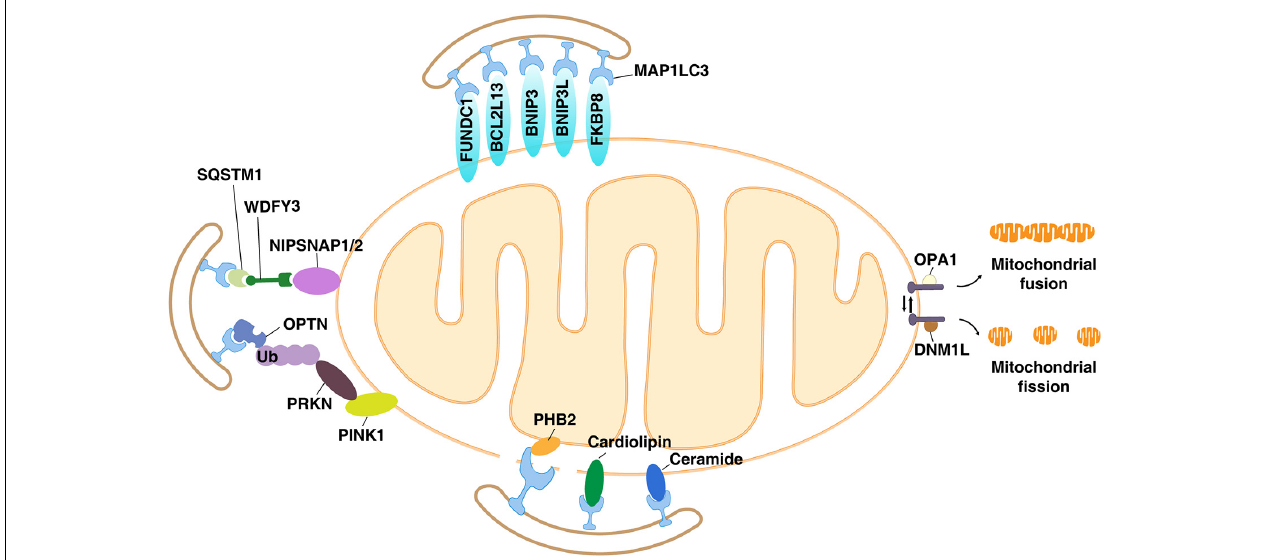
FIGURE 2 | The Ub-dependent and Ub-independent receptor pathways of mitophagy. Many components of the mitochondria, including mitochondrial membrane proteins (e.g., PINK1, BNIP3L, BNIP3, FUNDC1, NIPSNAP1, NIPSNAP2, BCL2L13, PHB2, and FKBP8) and lipids (e.g., cardiolipin and ceramides), act as mitophagy receptors in a context-dependent